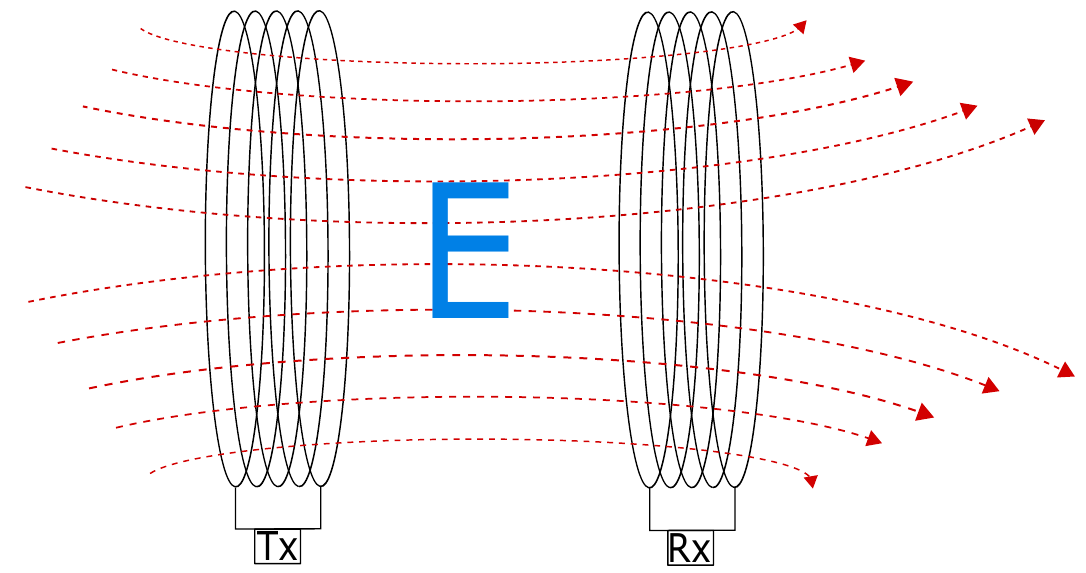
Figure 1. Electromagnetic field between the transmitter and receiver loops, which occurs due to changing polarity of the current